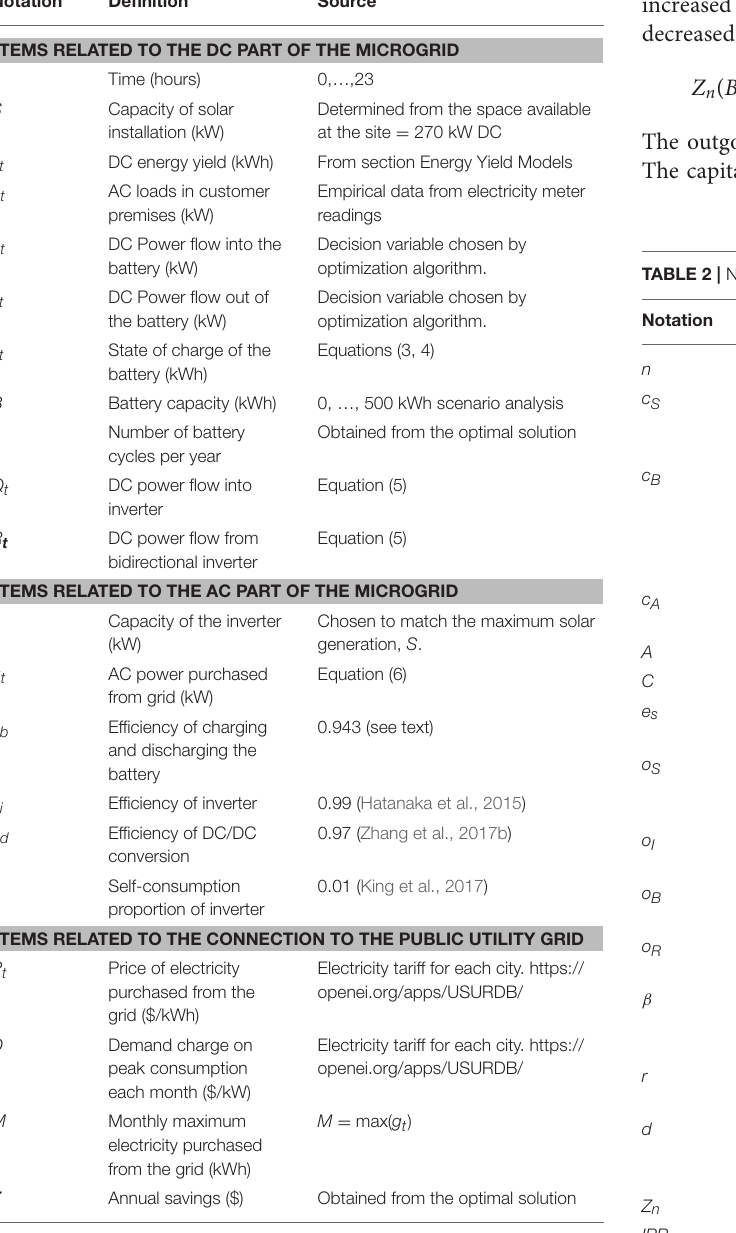
TABLE 1 | Notation and data sources used in microgrid